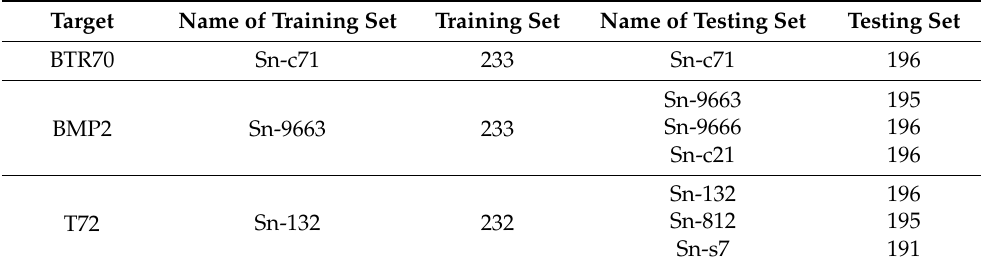
Table 1. The dataset of training and testing targets.